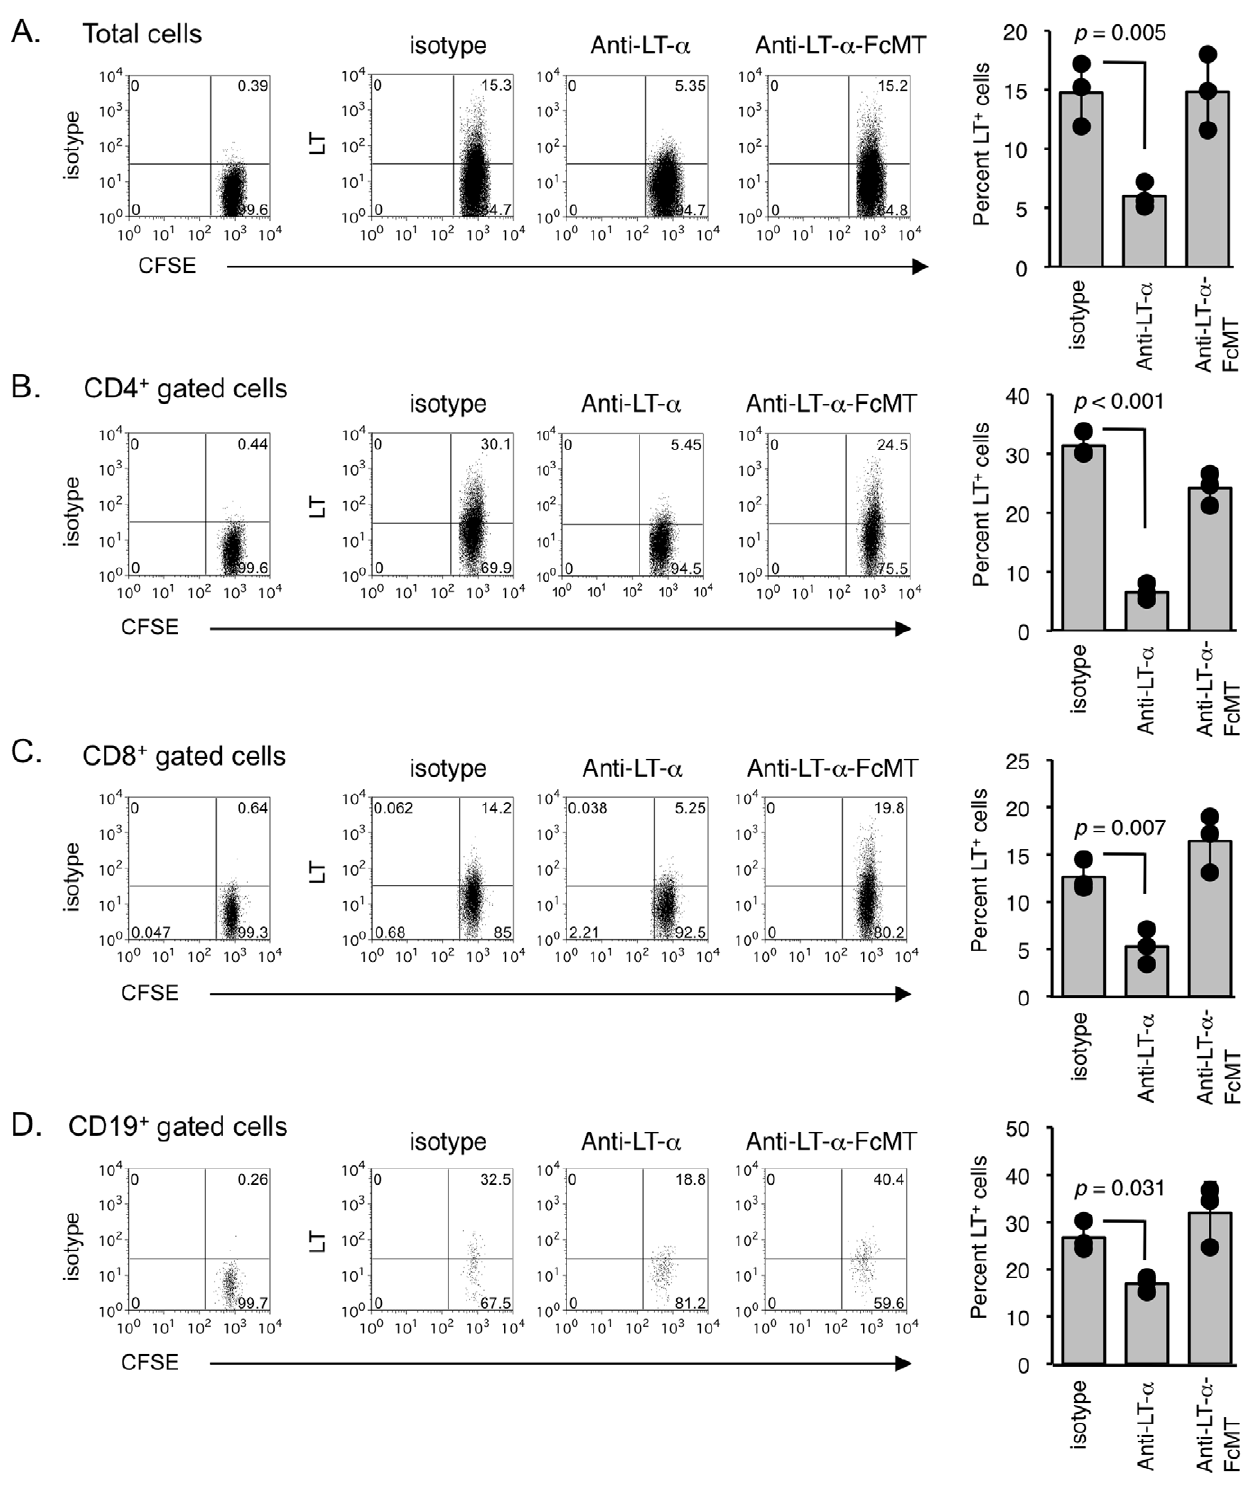
Figure 4. LT- a -specific mAb depletes LT-expressing human lymphocytes in Hu-SCID GVHD model. Spleens were harvested from SCID mice two days following intrasplenic injection of human PBMCs, after one day treatment with anti-LT- a MLTA3698A, anti-LT- a -FcMT or isotype control mAb. A . LT staining on total CFSE-labeled transferred cells and enumeration of percentage of total human cells expressing surface LT. B – D . LT expression and quantitation of mAb treatment effects on specific human lymphocyte populations. Spleen cells were gated on CD4 + cells ( B ), CD8 + cells ( C ) or CD19 + cells ( D ). In each experiment, 2–3 spleens were pooled to provide sufficient cell numbers for data collection. Data show staining for 1 pool out of 3 per experiment, and are representative of a minimum of 2 experiments for each cell type.